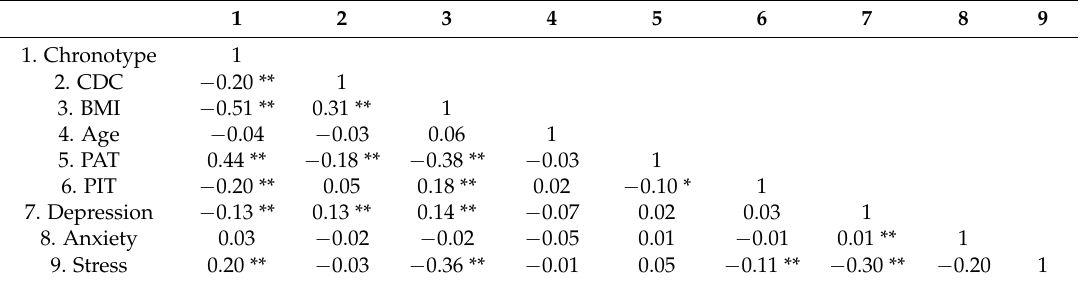
Table 2. Correlations of Key Study